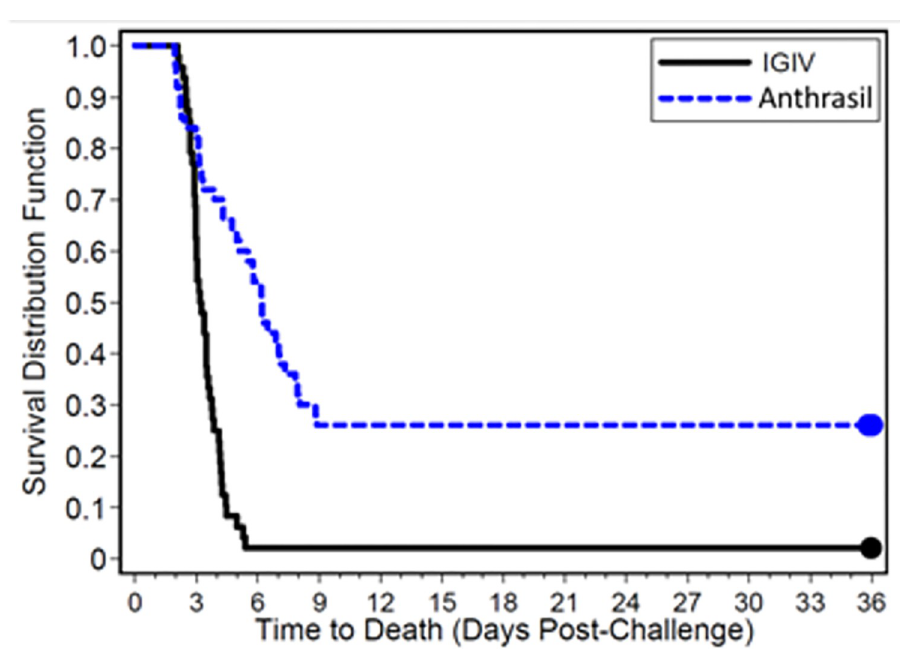
Fig 1. Kaplan-Meier curves representing time-to-death and survival data in B . anthracis -infected rabbits treated with IGIV or ANTHRASIL. Bacillus anthracis spore- challenged rabbits were treated with 15 U/kg ANTHRASIL or a matching volume of IGIV upon detection of toxemia. Only animals that received a full dose of ANTHRASIL or IGIV and were bacteremic at least once prior to treatment were included (Modified intent to treat analysis